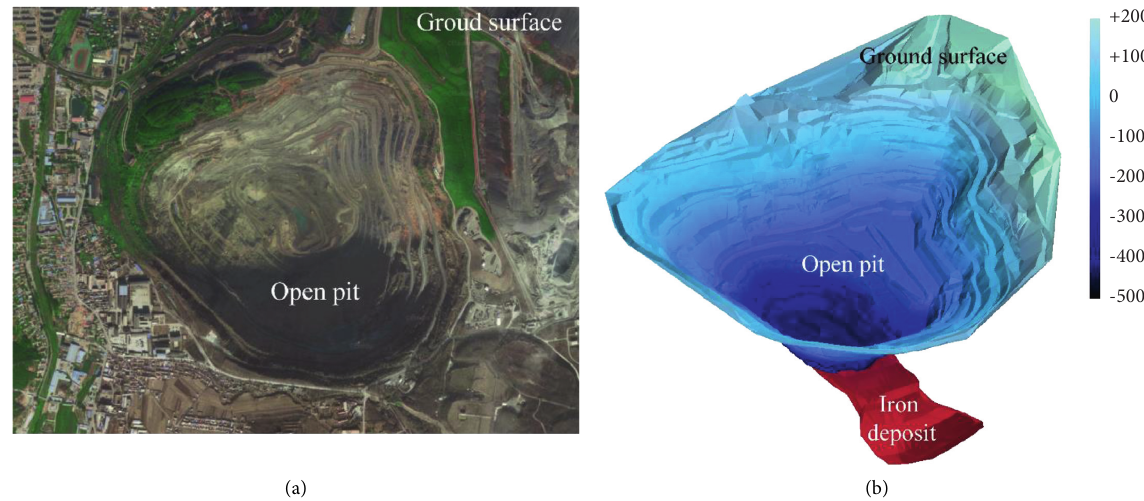
Figure 3: (a) Current open pit in the Dagushan iron mine, observed by satellite images; (b) 3D model of the current open pit and the iron deposit in the Dagushan iron mine.